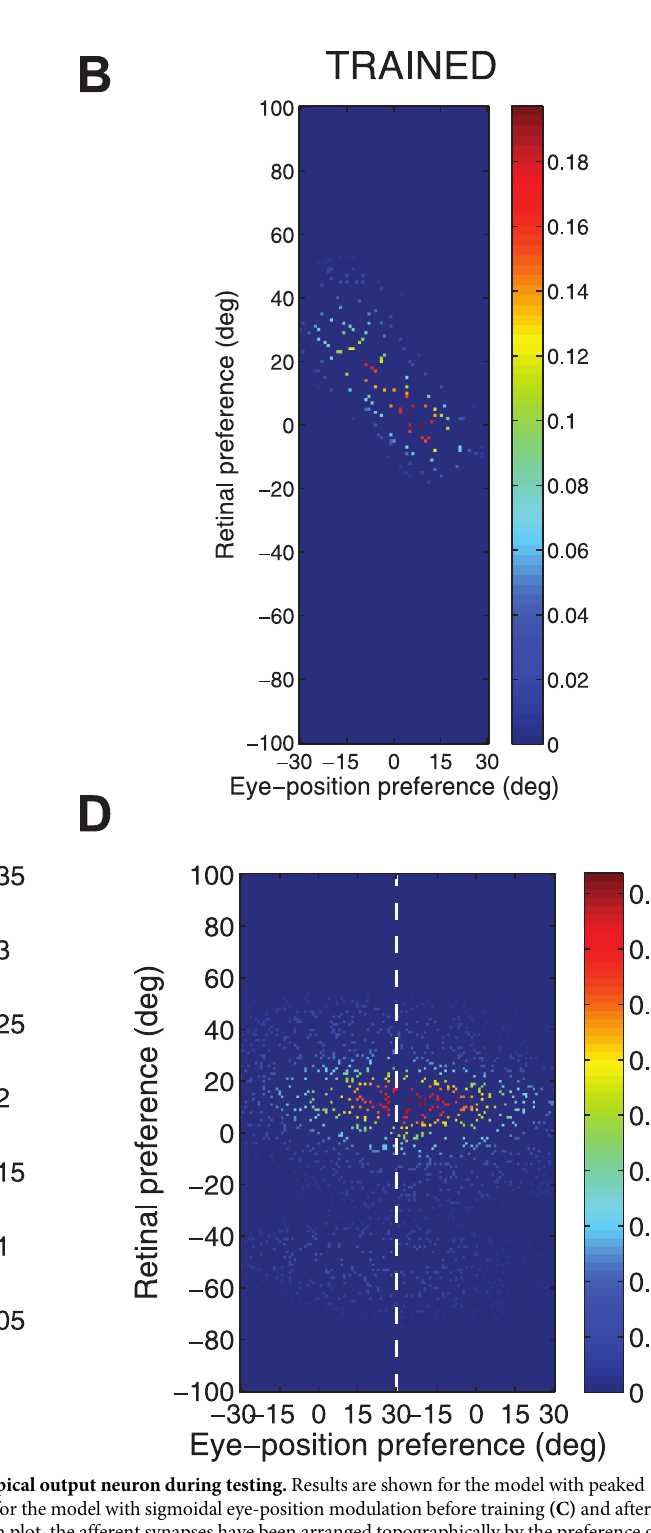
PLOS ONE | https://doi.org/10.1371/journal.pone.0207961 November29,